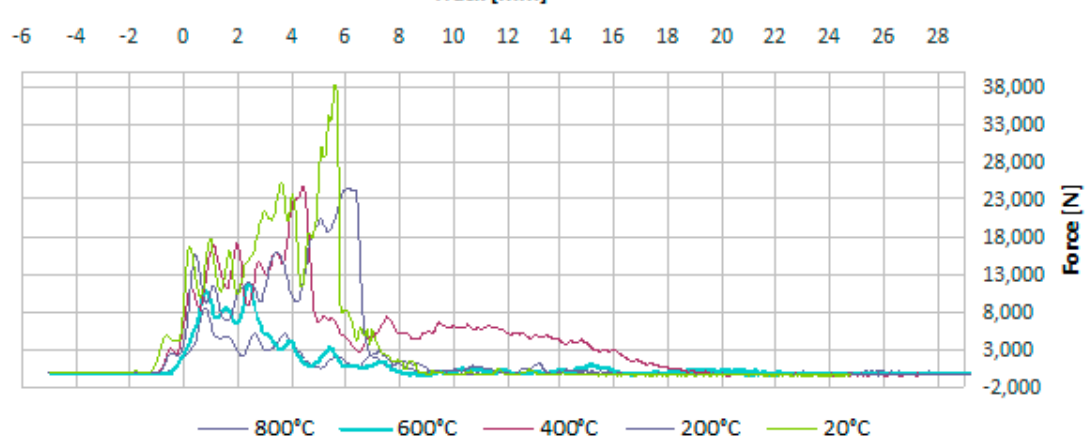
Figure 6. Examples of courses obtained from the implemented impact strength test: force-route.